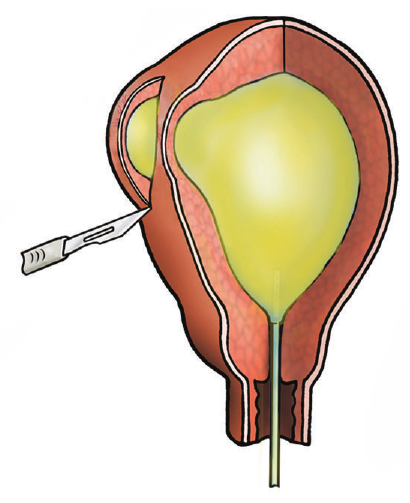
Figure 4: Inverting superficial polypropylene sutures were applied to the serosal layers overlaying the uterine muscle to prevent fibrosis or adhesion formation on the peritoneal